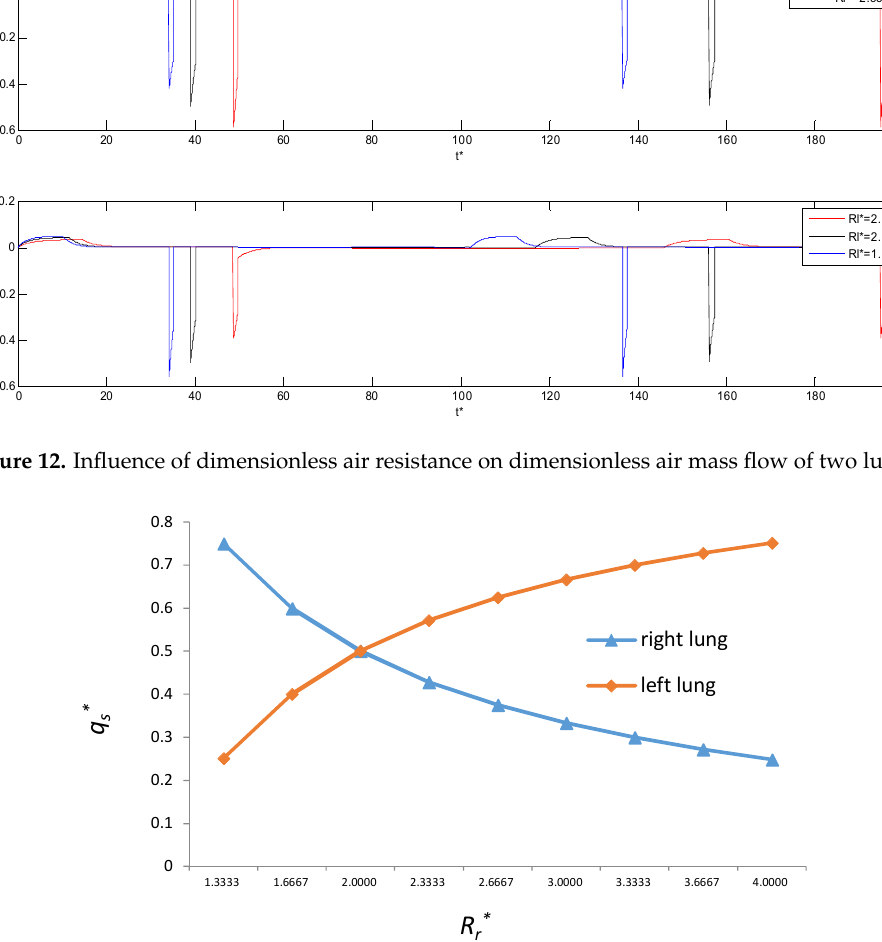
Figure 13. Influence of dimensionless air resistance on dimensionless peak suction flow of two lungs.